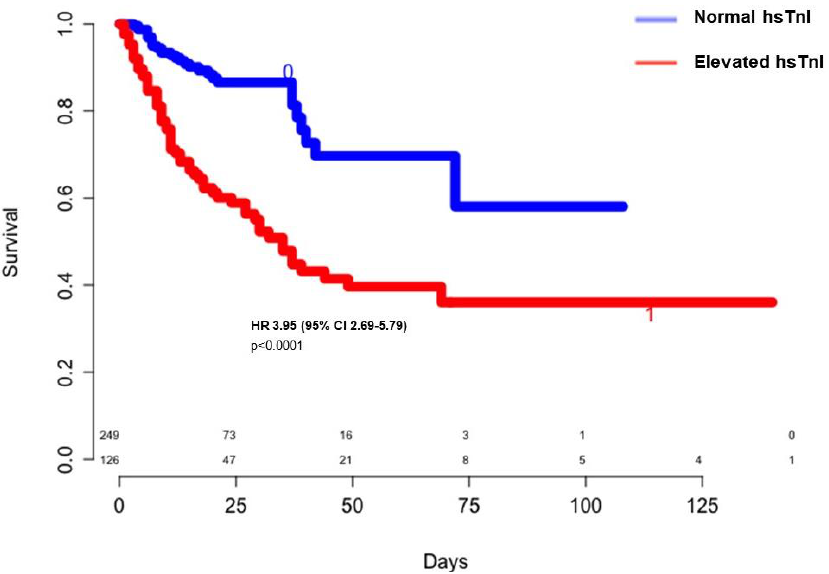
Figure 2. Crude survival rates according to high-sensitivity troponin levels. CI: confidence interval; HR: hazard ratio; hsTnI: high-sensitivity troponin I.